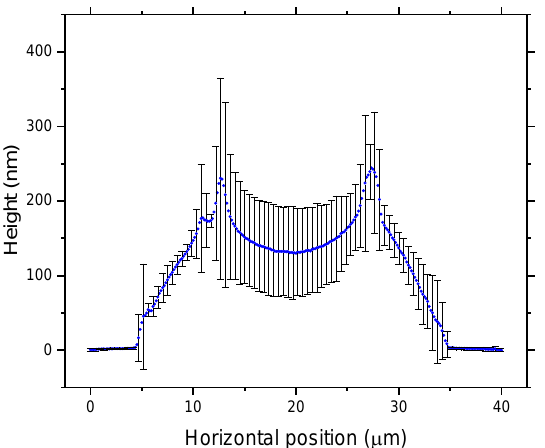
Figure 3. Changes in conductivity of PEDOT:PSS films when (3-glycidyloxypropyl)trimethoxysilane (GOPS) is added to PEDOT:PSS suspensions. The solid curve is a visual guide.